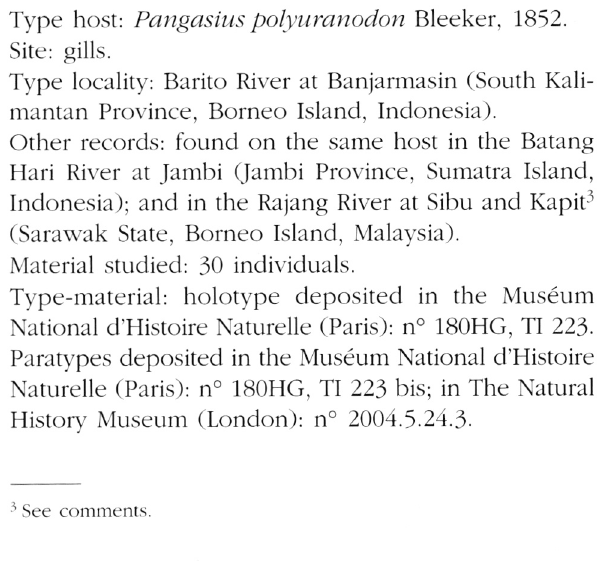
Adults: 440 ± 84.1 (300-610) long, 68 ± 11.5 (45-92) wide at level of penis. Pharynx: 28 ± 5.5 (19-40) wide. Dorsal gripus with blade bent at distal third,